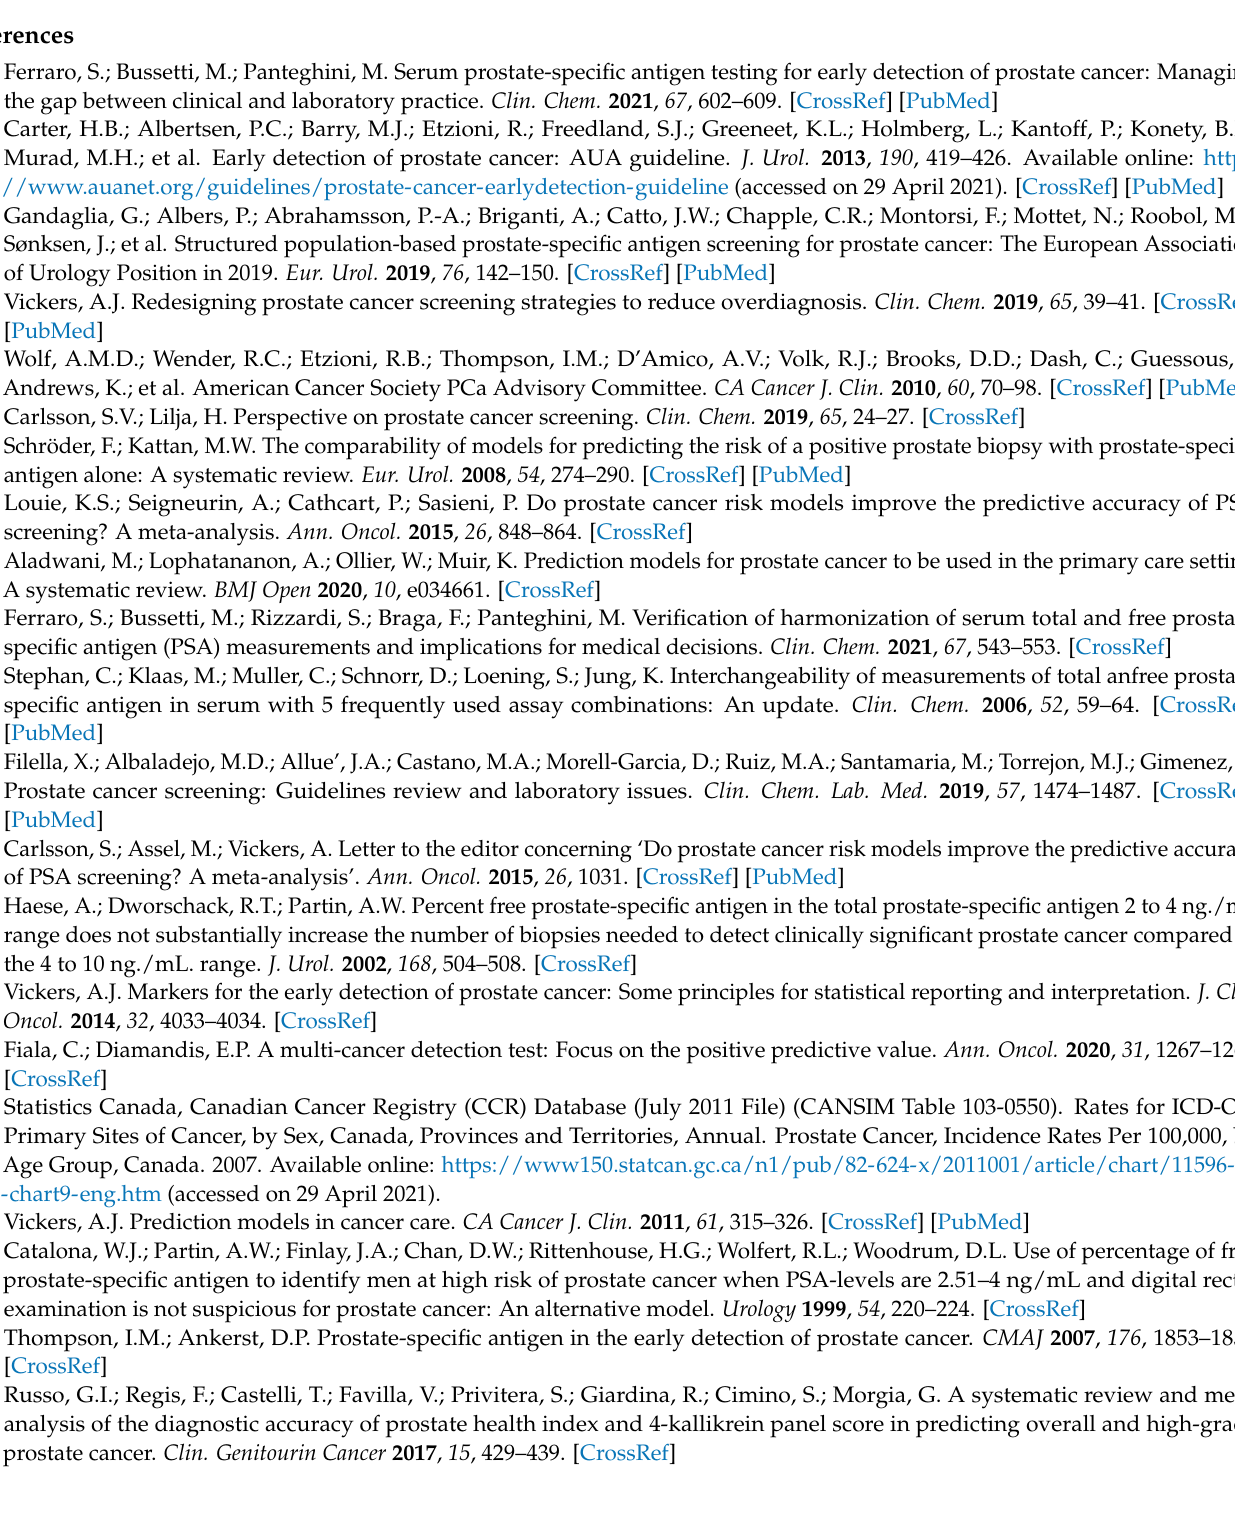
CPGs, clinical practice guidelines; PCa, prostatic cancer; PSA, prostate-specific antigen; PPV, positive predictive value; ISUP, International Society of Urological Pathology; AIC, Akaike information crite- rion; AUC, area under the ROC curve; LOWESS, locally weighted scatterplot smoothing; CI, 95% confidence interval; OR, odds ratio; NPV, negative predictive value; 4Kscore, 4-kallikrein panel